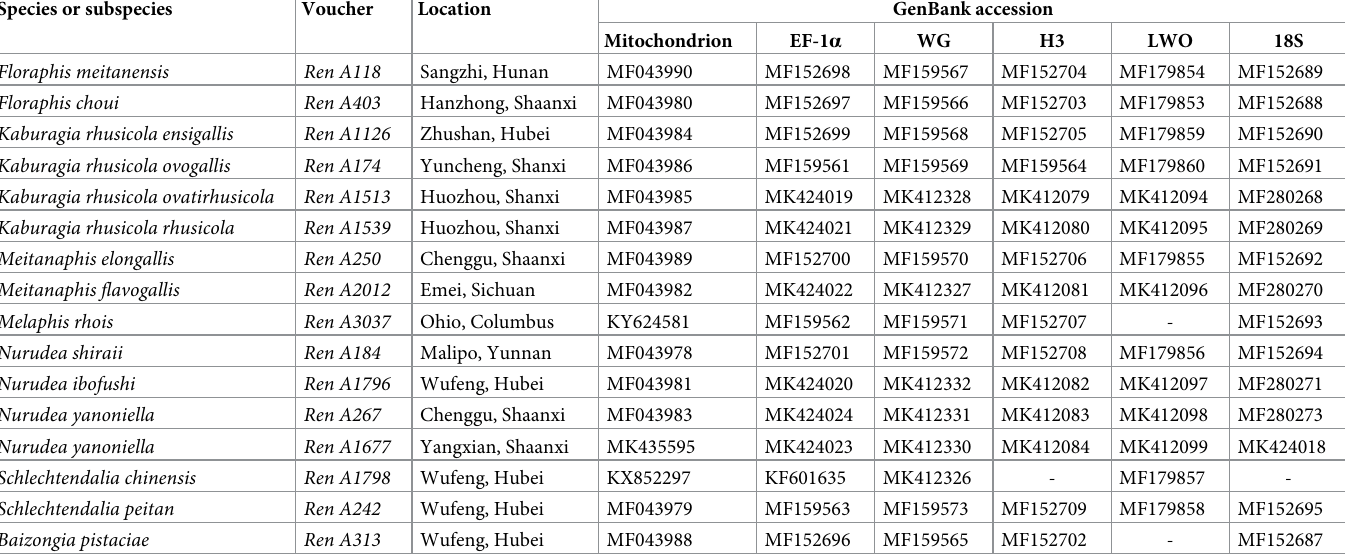
Table 1. Collection information for the Melaphidina aphid samples and outgroups used in this study. All the aphid specimens were alate viviparous females and we identified them according to the taxonomy of Zhang et al. [1]. All the samples were collected from China except for Melaphis rhois from United States of America